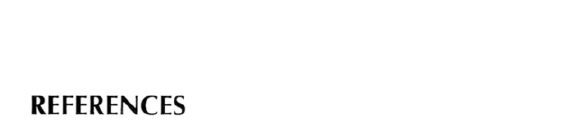
FIGURE 15 Perturbed ball motion versus nondi mensional time (w = 0.7). Initial conditions: i o(O) = .90(0) = 0.01 , i o(O) = Yo(O) = 0, cf>s) = 3.13, cf>s2 = 3.15, cf»(0) = cf>2(0) = 0.01, ~)(O) = ~2(0) = 0, rn = 0.005, R = 0.001, and {3' =